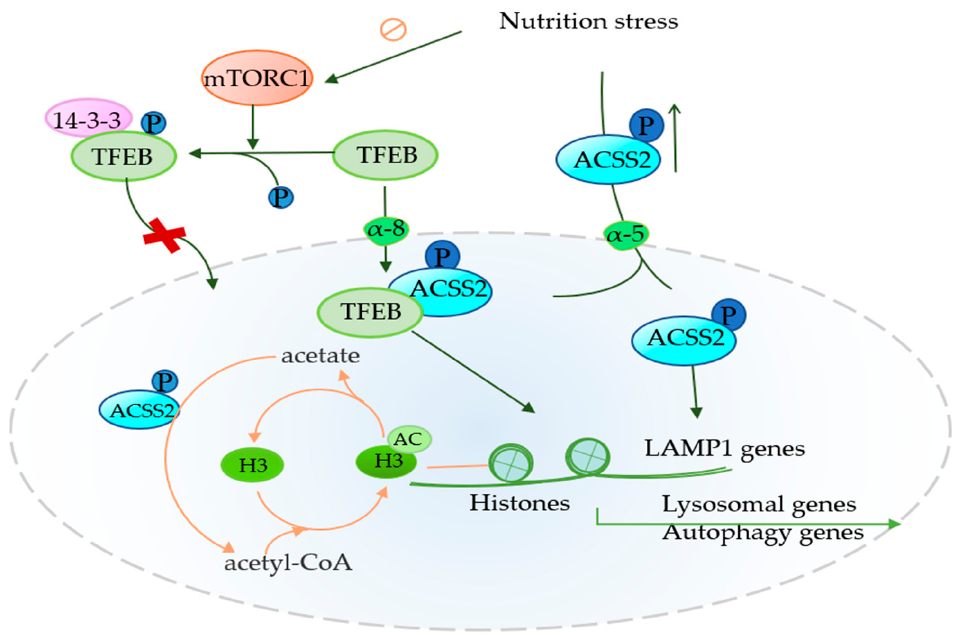
Figure 2. Role of ACSS2 in autophagy Phosphorylated ACSS2 enters the nucleus mediated by α -5 and forms a complex with TFEB mediated by α -8 in the promoter regions of lysosomal and autophagy genes, where ACSS2 incorporated acetate from the turnover of histone deacetylation into acetyl-CoA for histone H3 acetylation (the orange line segment represents the cycle between histone H3 and acetylated histone H3). Besides, ACSS2 enhance LAMP1 gene expression, which ultimately promote lysosomal biogenesis and autophagy. α -8: importin 8.